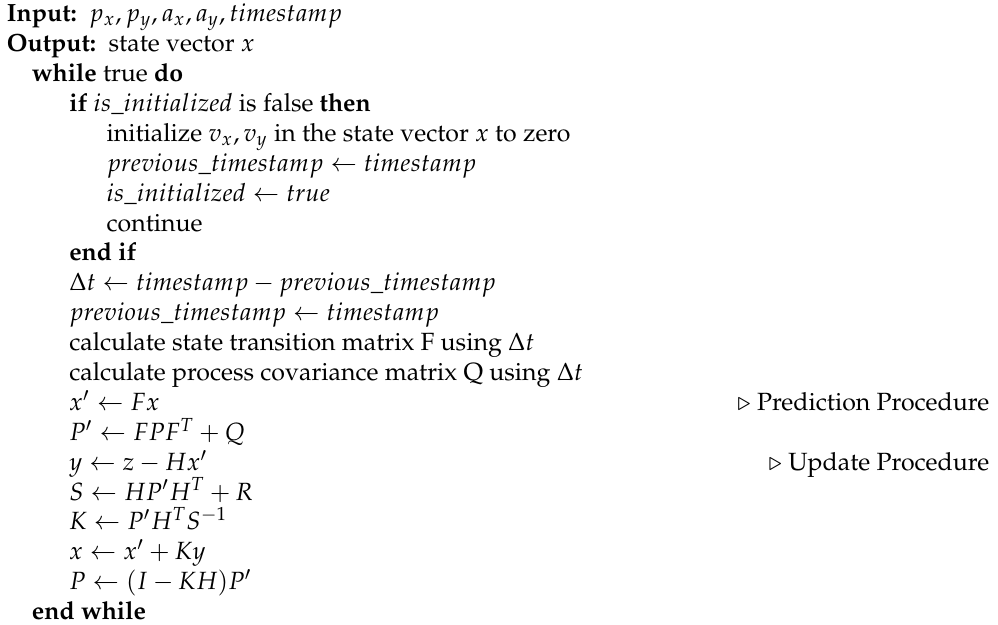
Algorithm 1 Algorithm of the sensor fusion UWB and